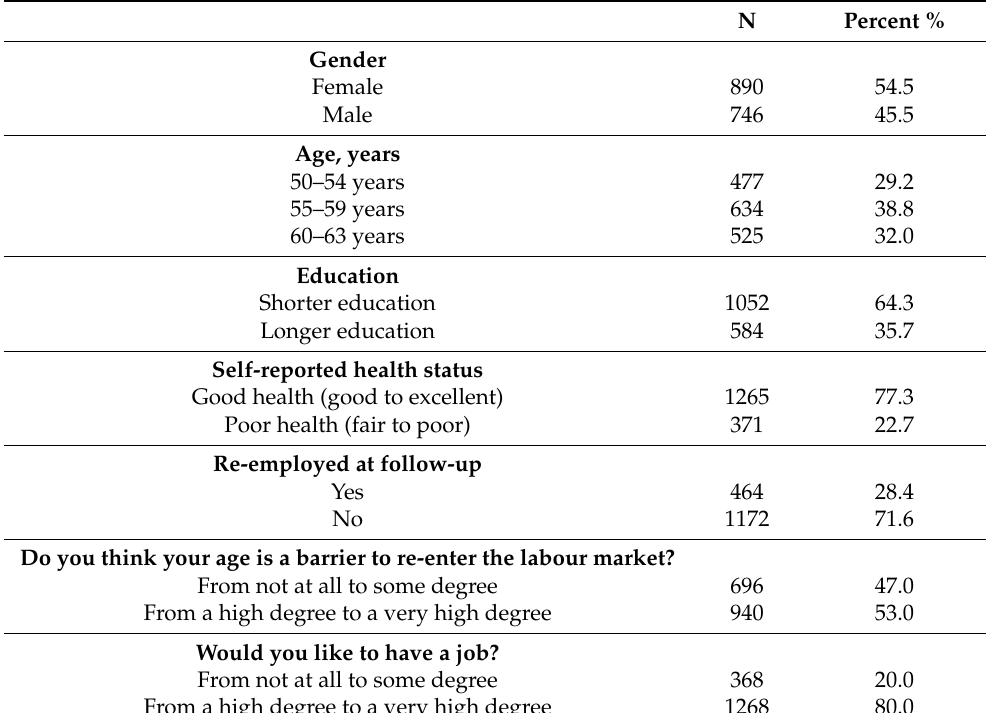
Table 1. Characteristics of the study